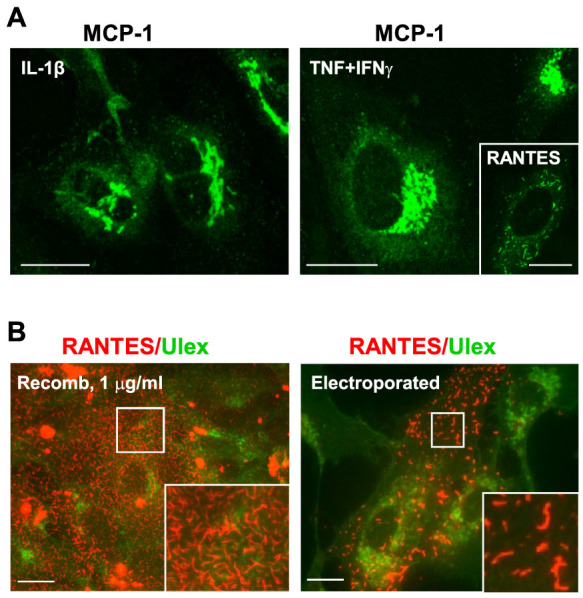
Filaments of RANTES form independently of TNFα and
IFNγ-stimulation.(A) HUVECs were stimulated with 1 ng/ml IL-1β, or 10 ng/ml
TNFα in combination with 1 ng/ml IFNγ for 24 h and
immunostained with an antibody towards MCP-1. The insert shows
immunostaining of RANTES from the same experiment, in HUVECs stimulated with
10 ng/ml TNFα + 1 ng/ml IFNγ. (B) Left image; HUVECs
were incubated with 1 μg/ml recombinant RANTES before fixation
and immunostaining. Right image; HUVECs were not stimulated but
electroporated with a DNA plasmid encoding RANTES before fixation and
immunostaining of RANTES with a rabbit anti-RANTES antibody. Labelling with
ulex (green) was included to visualize individual cells. Scale bars,
10 μm. All images were acquired by confocal microscopy.